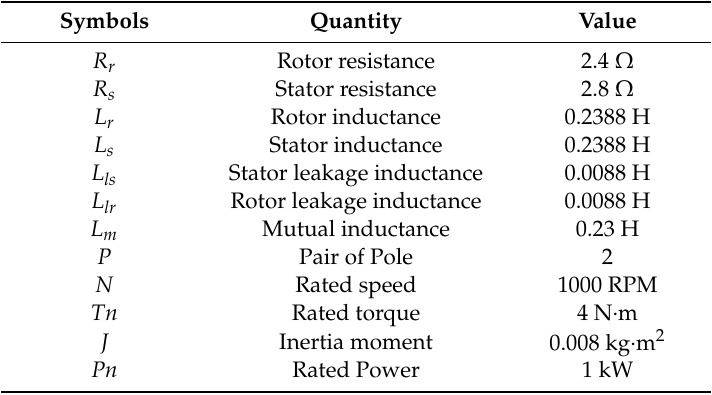
Table 1. Motor data.